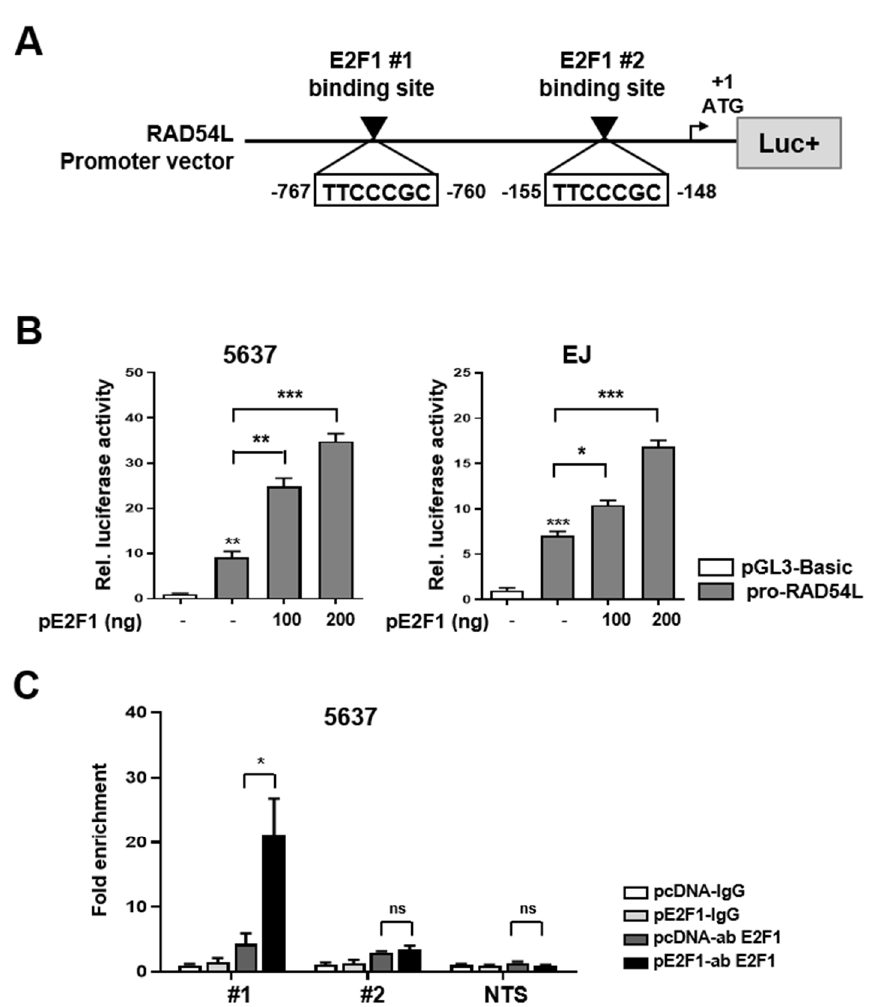
Figure 3. E2F1 is involved in transcriptional activation of RAD54L gene. ( A ) Schematic diagram of RAD54L promoter vector map shown by E2F1 binding sequence. White boxes denote putative E2F1 #1( − 767 / − 760), #2( − 155 / − 148) binding sites. The first ATG is indicated by a black